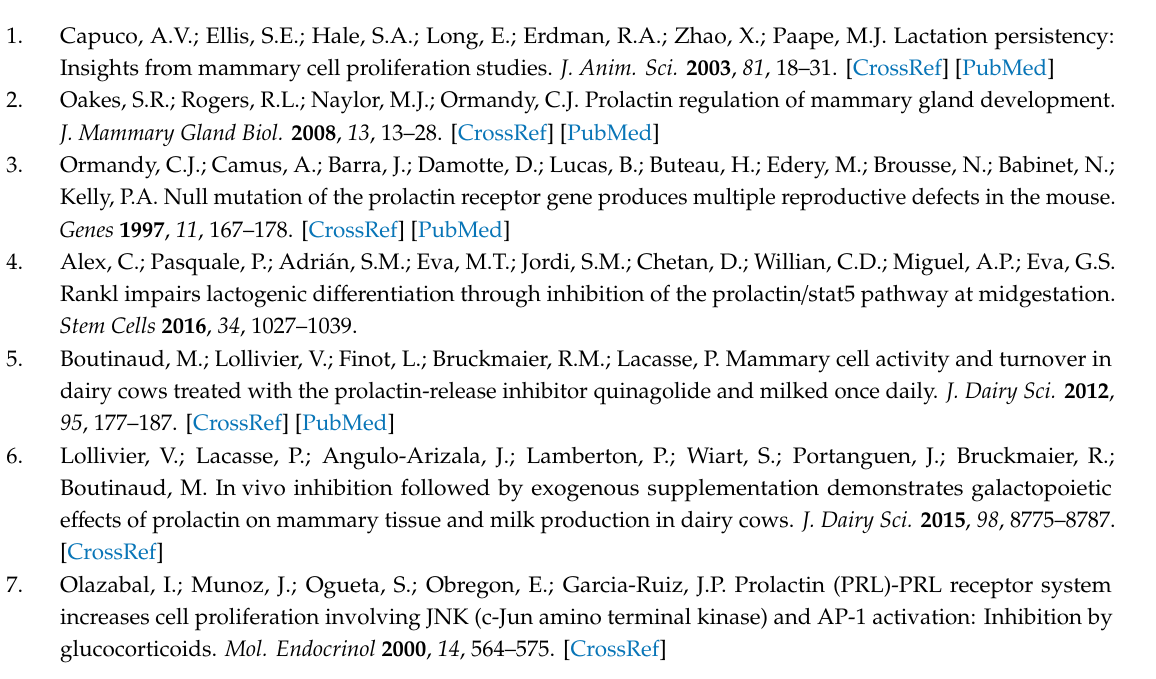
Figure S1: The structure diagram of splicing sites, Figure S2: Relative expression of circHIPK3 and HIPK3 mRNA under PRL treatment in mammary gland cells, Figure S3: PRL a ff ects expression of alternative splicing factors, Table S1: Primer sequence information, Table S2: Relative di ff erentially expressed circRNA transcripts between the control and PRL